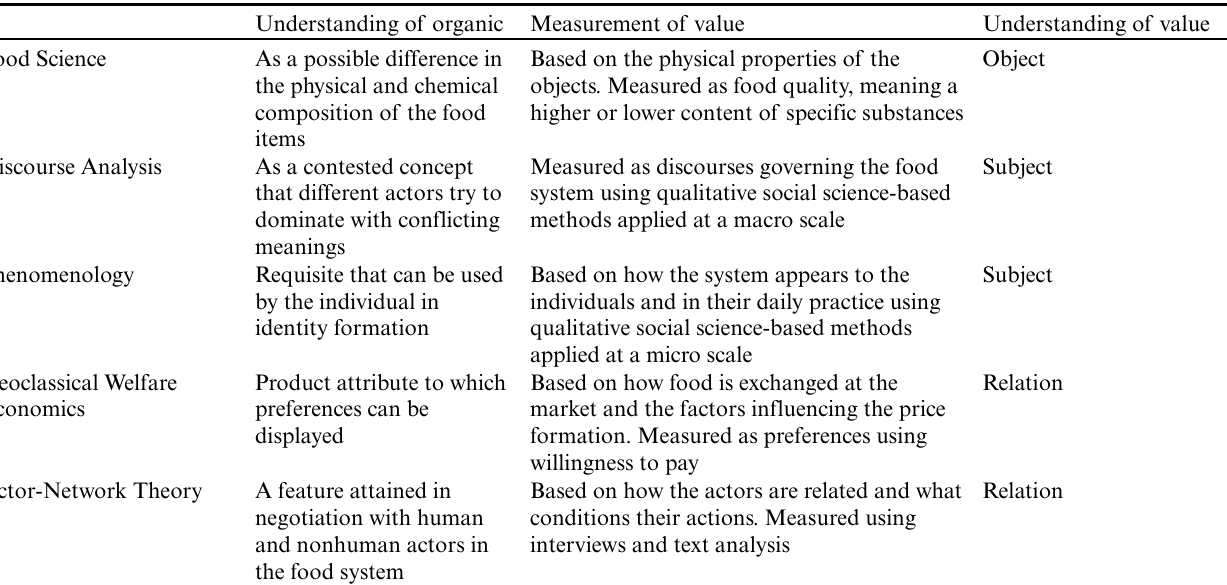
Table 1 . Main features of the five perspectives presented in the